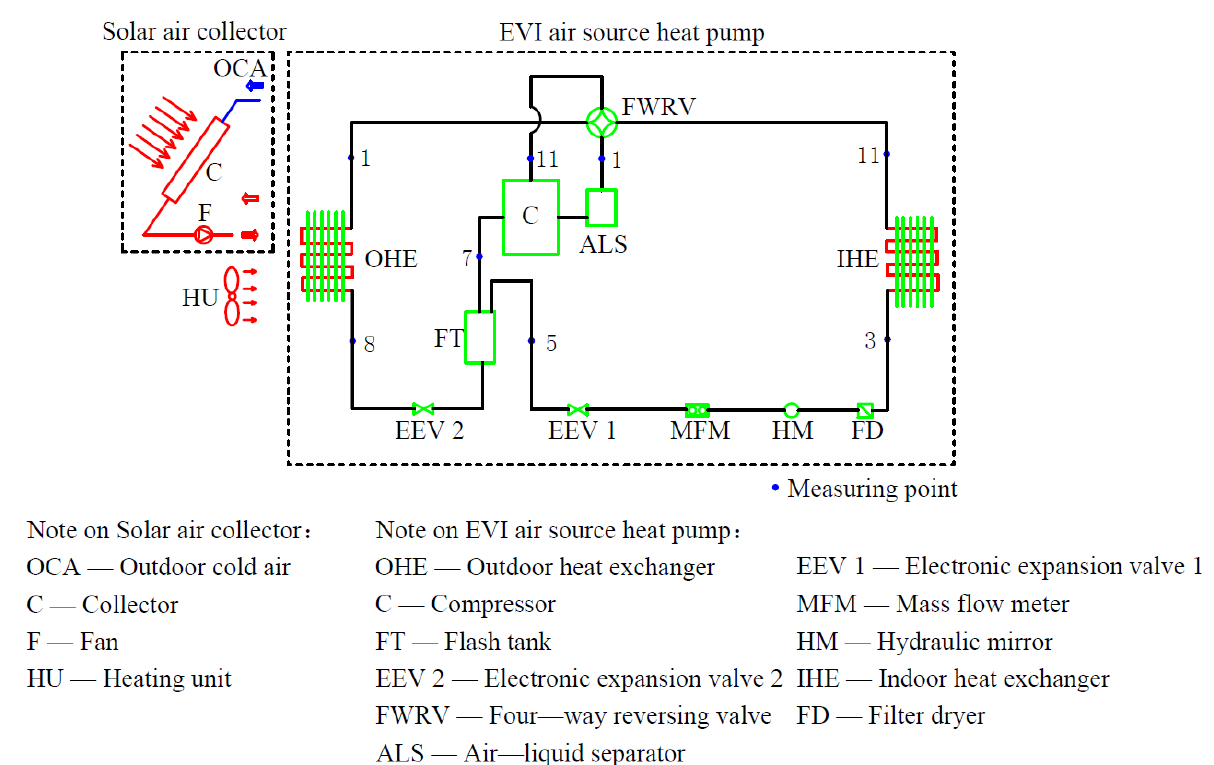
Figure 1. Experimental principles and measurement point layout diagram of the SC ‐ EVIHP system.